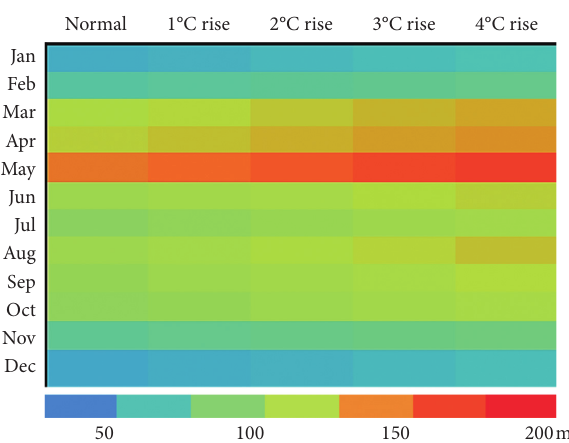
Figure 2: Change in monthly total reference crop evapotranspi- ration under climate change scenarios in